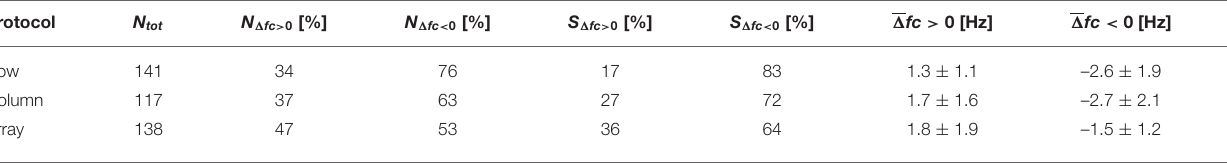
TABLE 1 | Change of average frequency from the CWT during photostimulation where 1 fc = fc dur − fc bef .